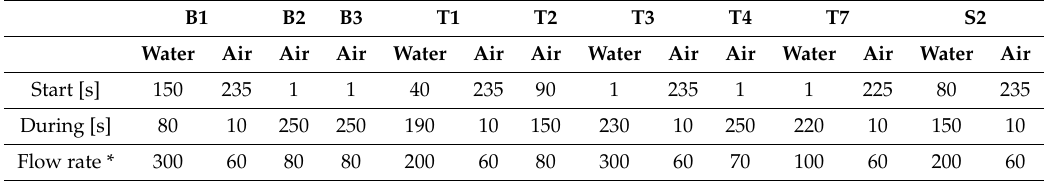
Table 3. Cooling parameters of the non-production process